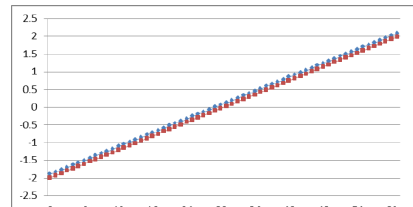
Figure 1. The angle between solar orientation vector and the Y axis of the sensor coordinate system